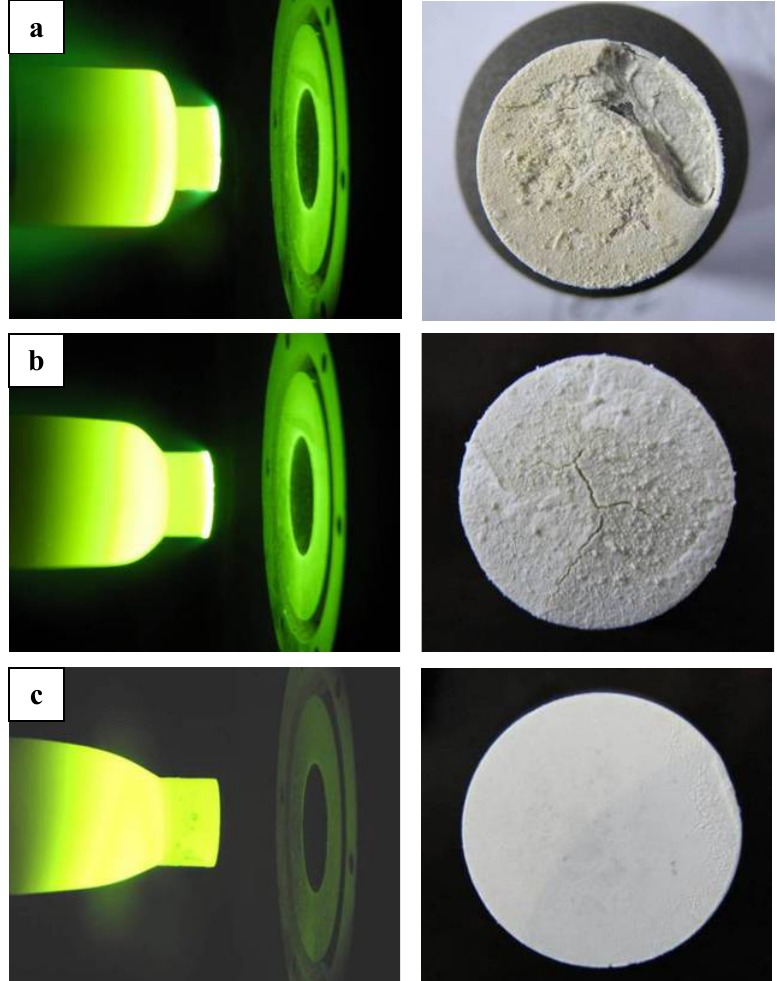
Figure 1. Photographs of ZrB based ultra high temperature ceramic composites during 2